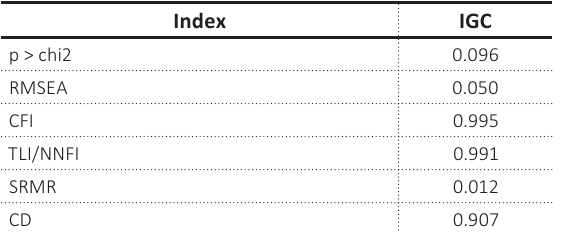
Table 5. Goodness of fit indices for the IGC